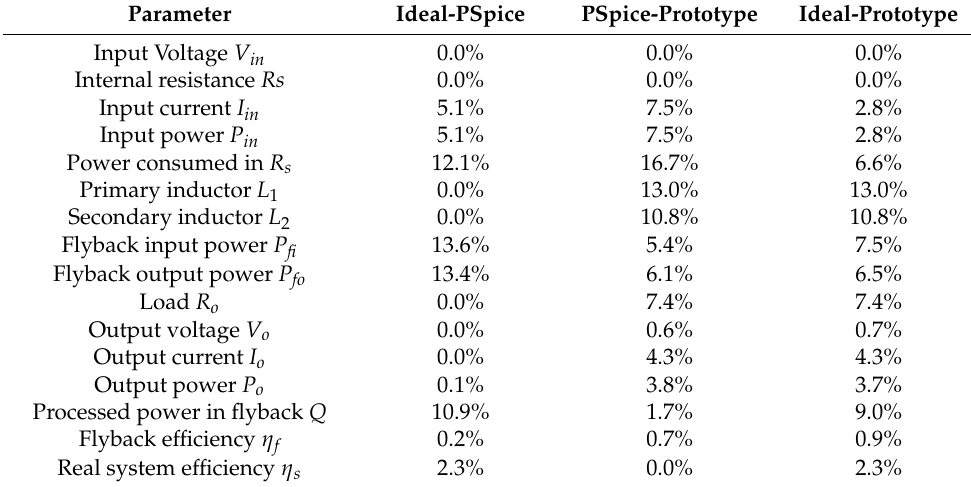
Table 5. Percentage error.